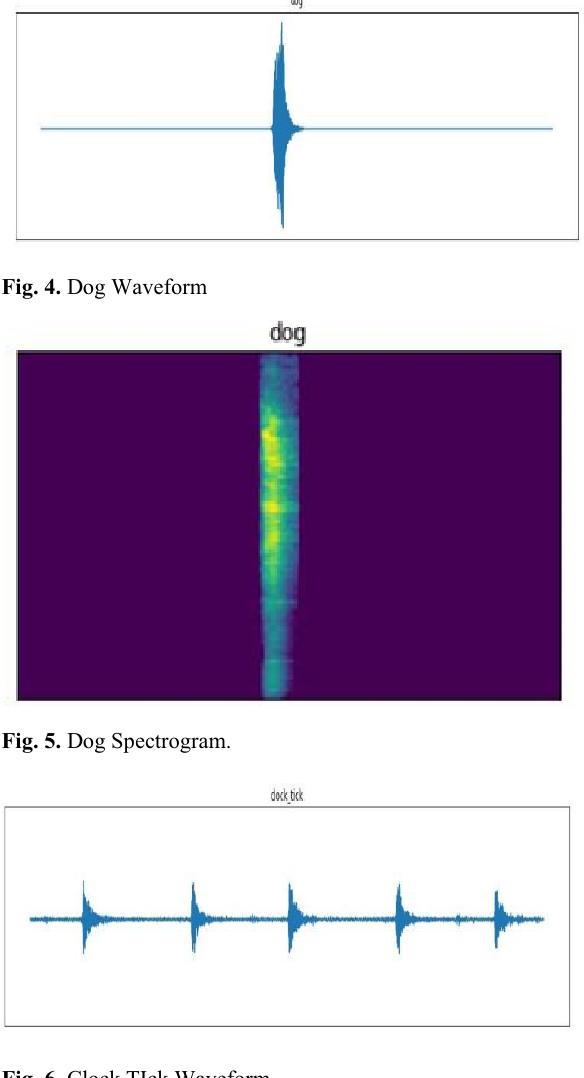
Fig. 6. Clock TIck Waveform.